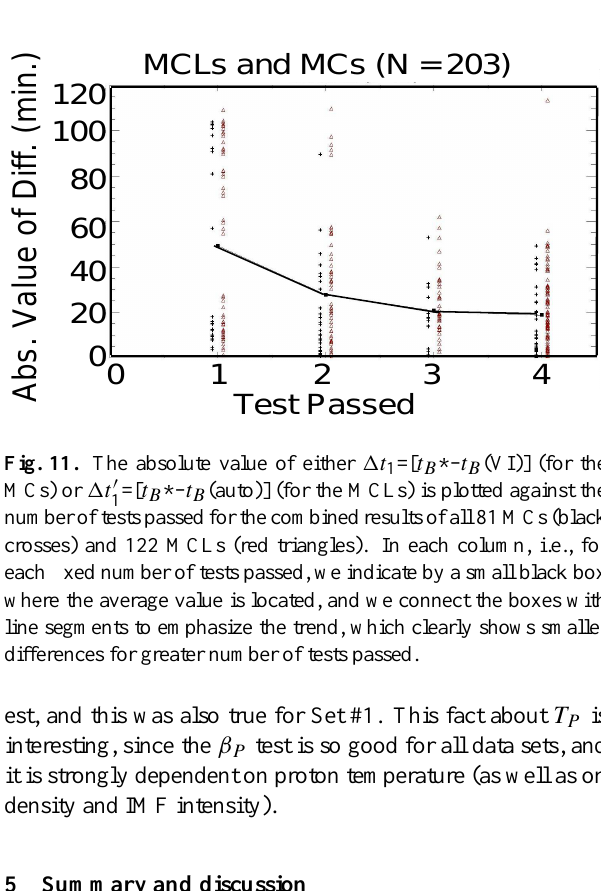
Fig. 10. Histograms giving the number of MCs that contributed to the estimate of a given 1t 1 i =[ t B * i – t B (VI)] ( i =1, ..., 4), individually for the following: test #1 ( A , DD test), test #2 ( B , 1β P ) , test #3 ( C , 1 Temp.), and test #4 ( D , 1 | B | ) for the N (total)=81 MCs of Data Set #3, based on the 5min averages. The subscripts in the 1t 1 i -equation here mean that the 1t 1 ’s for every individual test’s estimate are being shown, not just the average 1t 1 .